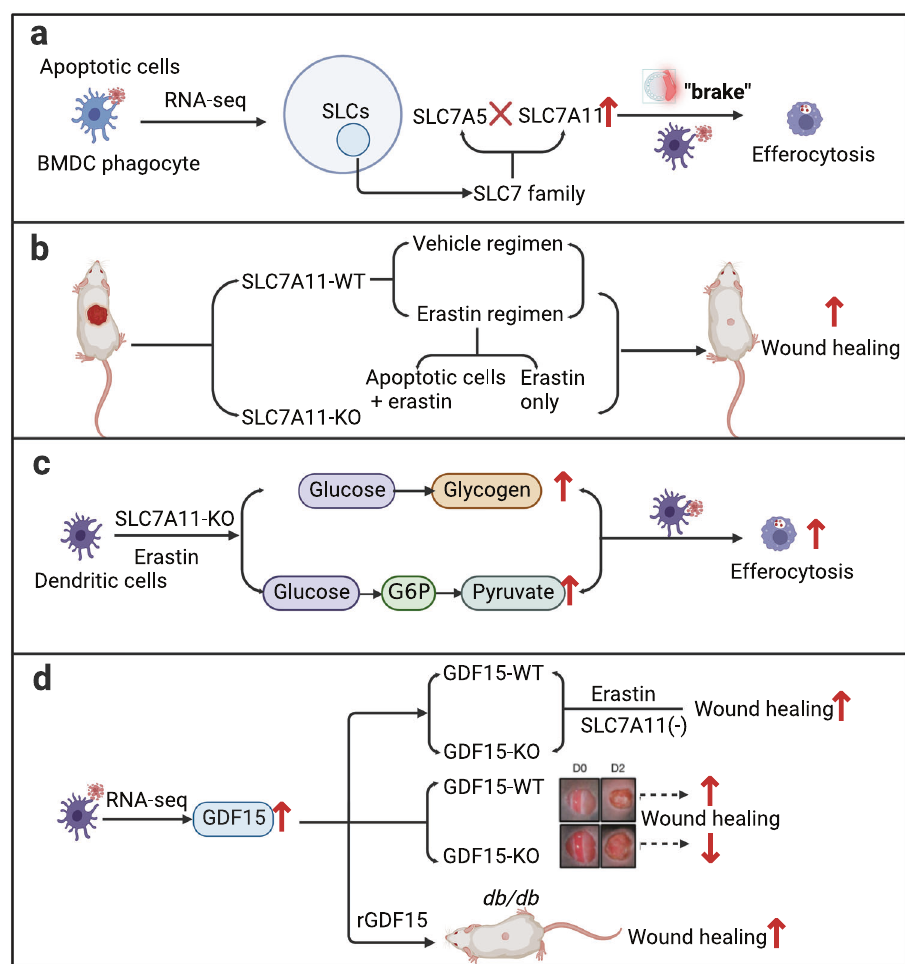
Fig. 1 Boosting efferocytosis improves diabetic wound healing via targeting SLC7A11 in dendritic cells (DCs). a SLC7A11 acts as brake on DC efferocytosis, which was revealed by RNA-seq in DCs during efferocytosis. b Interfering with SLC7A11 function affected wound healing dynamics by erastin co-administering early-stage apoptotic cells in vivo. c Efferocytosis in DCs enhanced via glycogenolysis with inhibition or knockout of SLC7A11 in vitro. d SLC7A11 inhibition at the wound site can boost diabetic wound healing by improving apoptotic cell clearance and GDF15 secretion. Created with